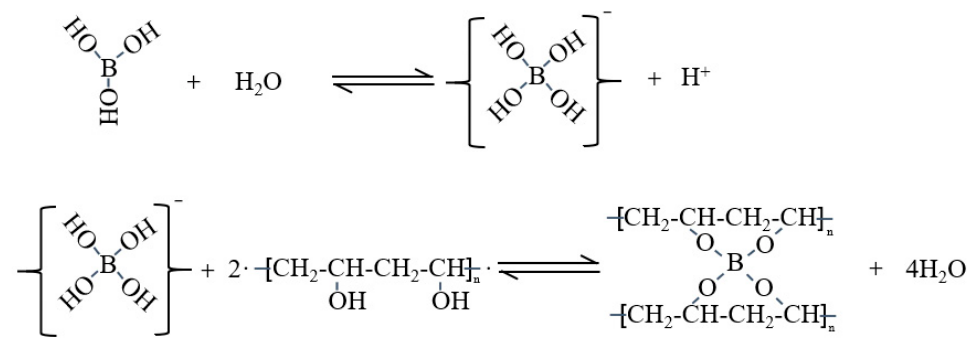
Figure 8. Reaction process of BA and PVA.